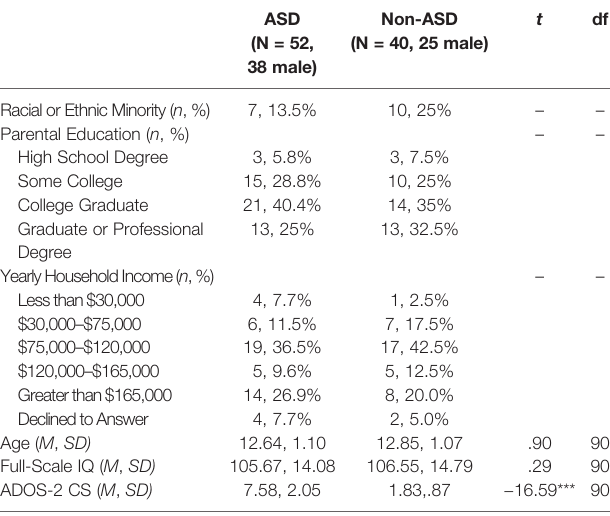
TABLE 1 | Descriptive Statistics and Independent Samples t-Tests Comparing Age, Full-Scale IQ, and ADOS-2 CS Across Participants in the ASD and Non- ASD